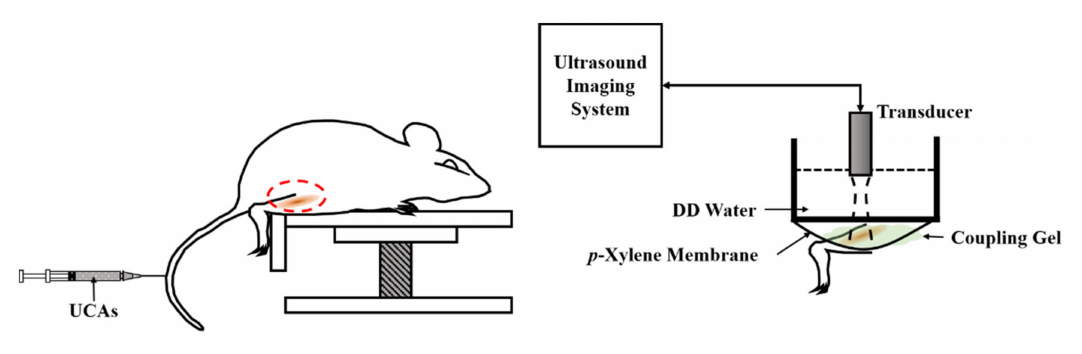
Figure 4. The arrangement for in vivo animal